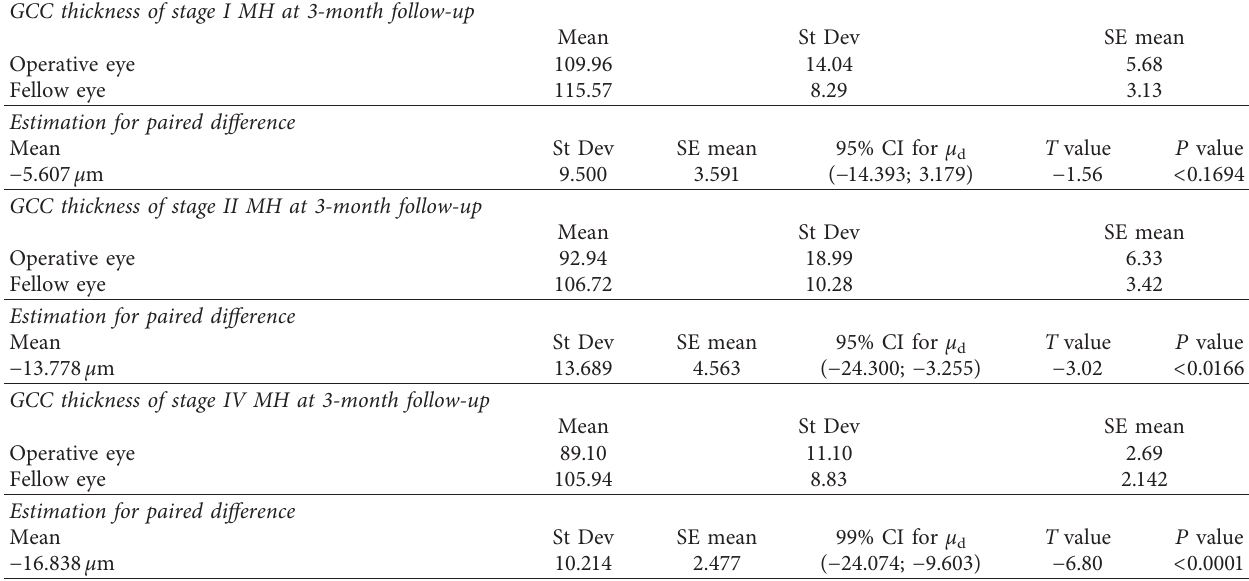
Table 6: Comparison between GCC thickness of the operated eye and contralateral healthy eye in the three groups at three-month follow- up.